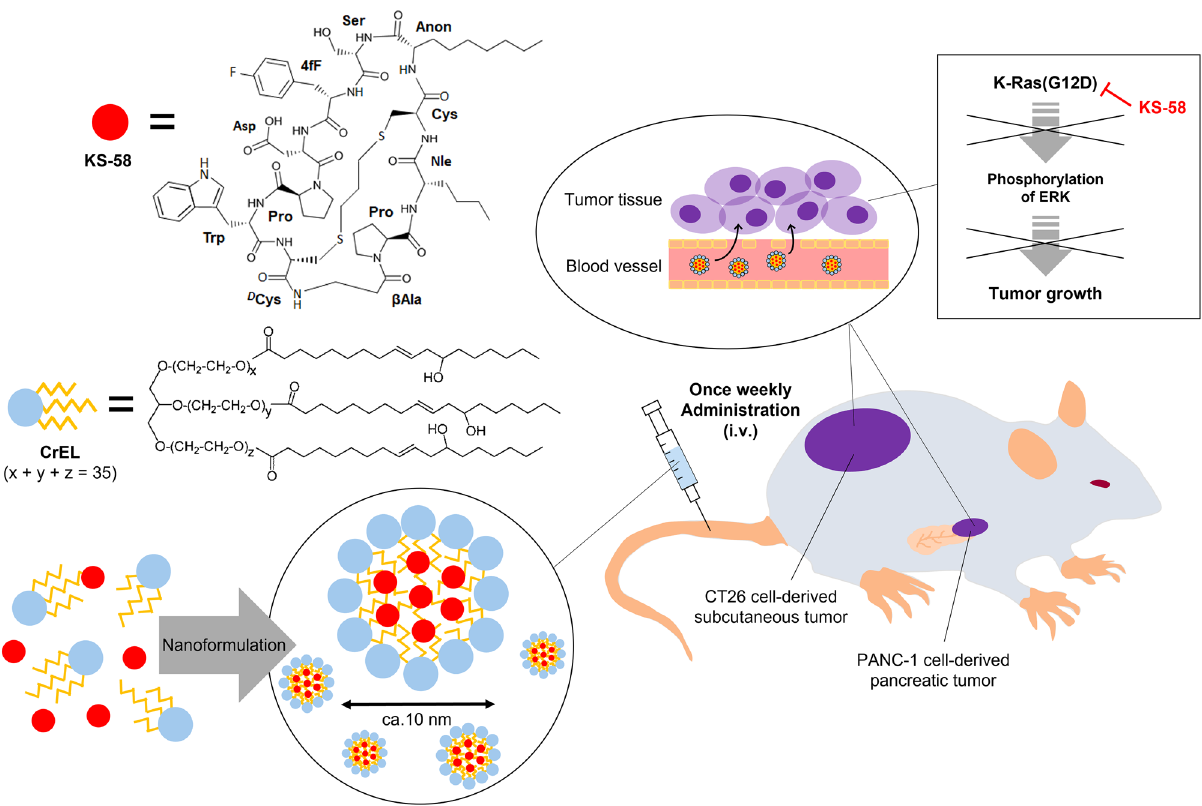
Figure 1. Schematic diagram for this